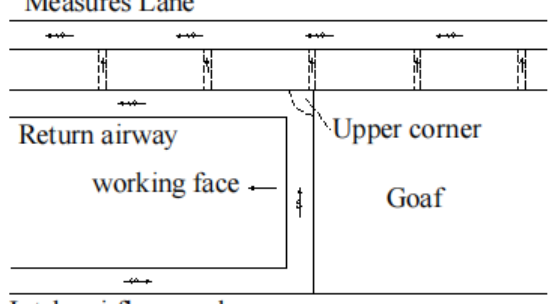
Figure 1. Layout of the working